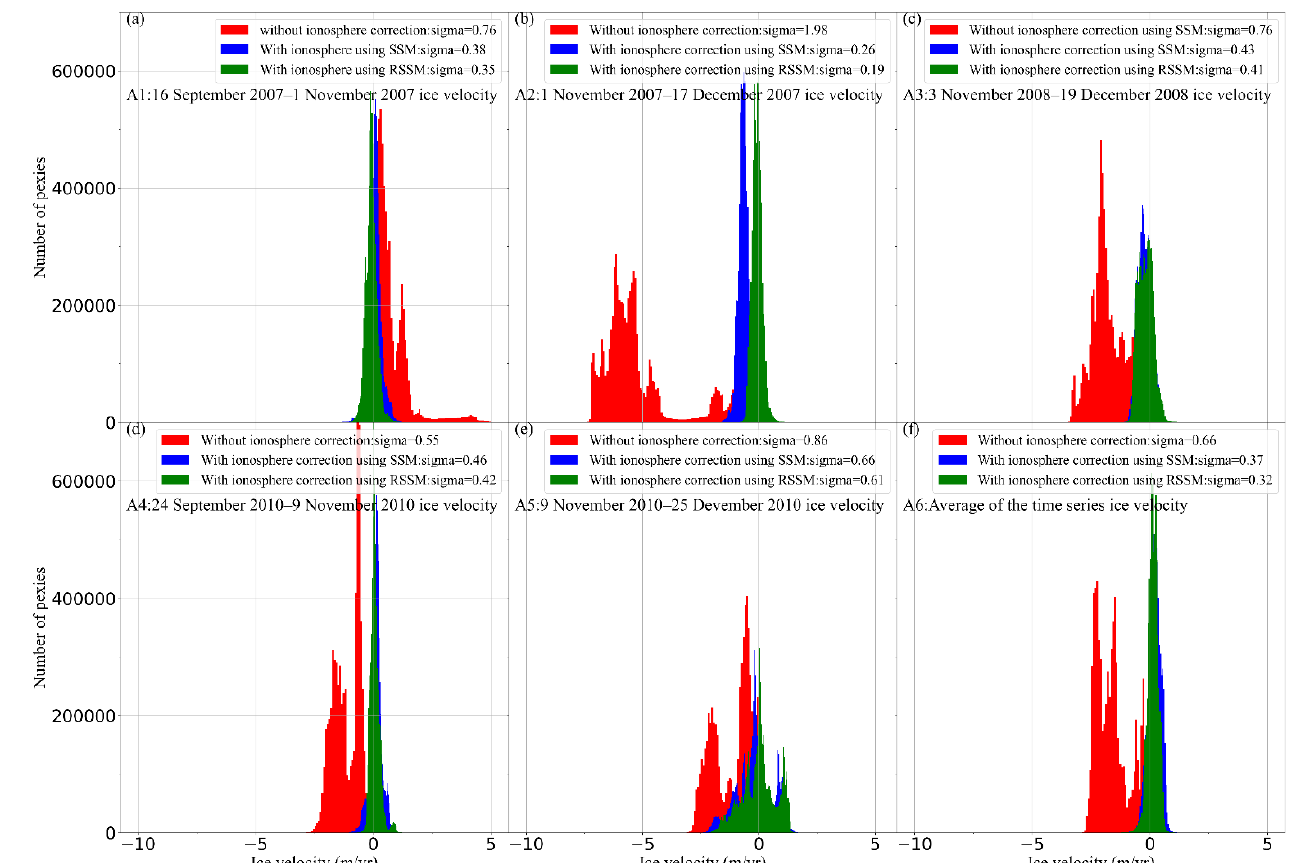
Figure 10. The statistical histogram of measurement biases between time-series ice velocity and MEaSUREs ice velocity; ( a ) between A1 and MEaSUREs; ( b ) between A2 and MEaSUREs; ( c ) between A3 and MEaSUREs; ( d ) betweenA4 and MEaSUREs; ( e ) between A5 and MEaSUREs; ( f ) between A6 and MEaSUREs.